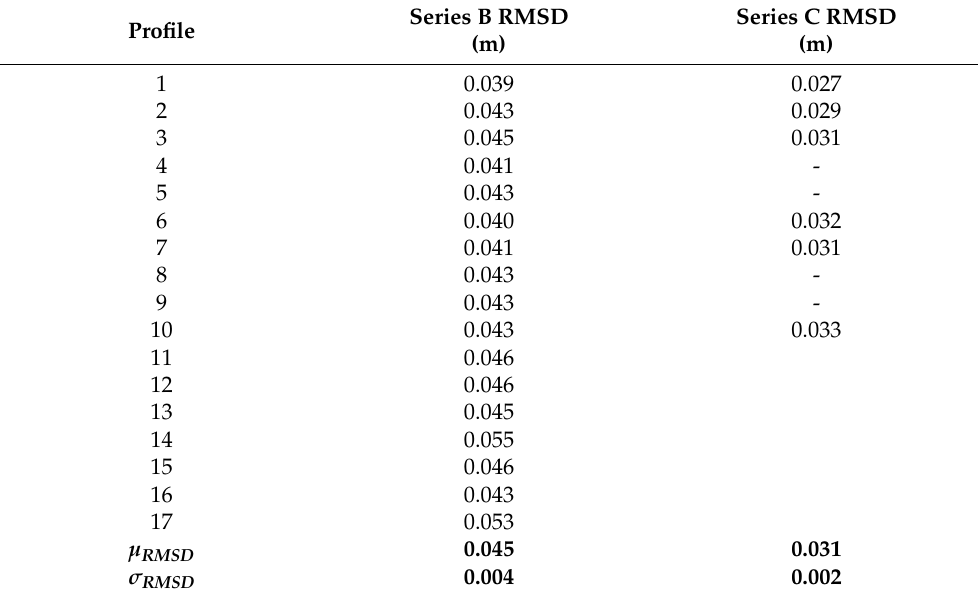
Table 1. Statistical comparisons between LLC LiDAR and FRF DUNE LiDAR time-averaged beach profile elevations. Profile numbers are defined in Figure